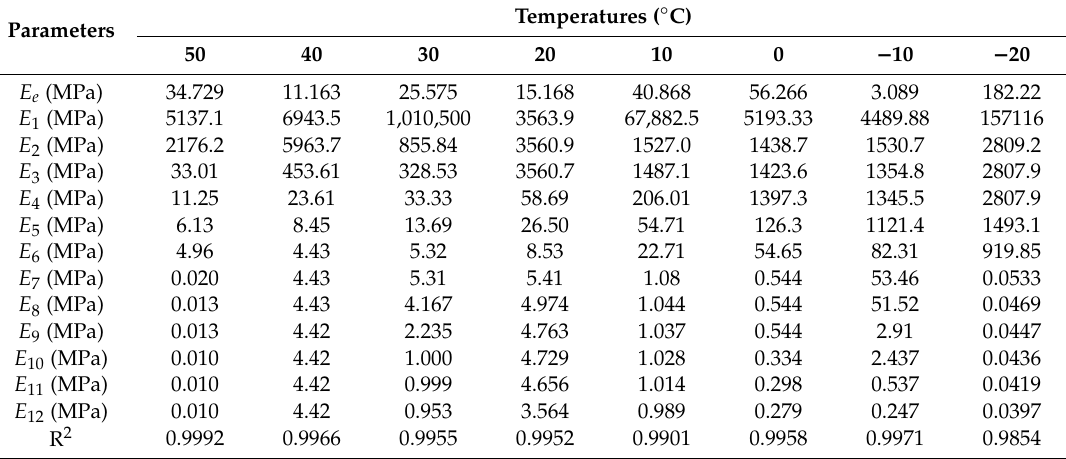
Table 9. The fitting parameters of AM based on the generalized Maxwell